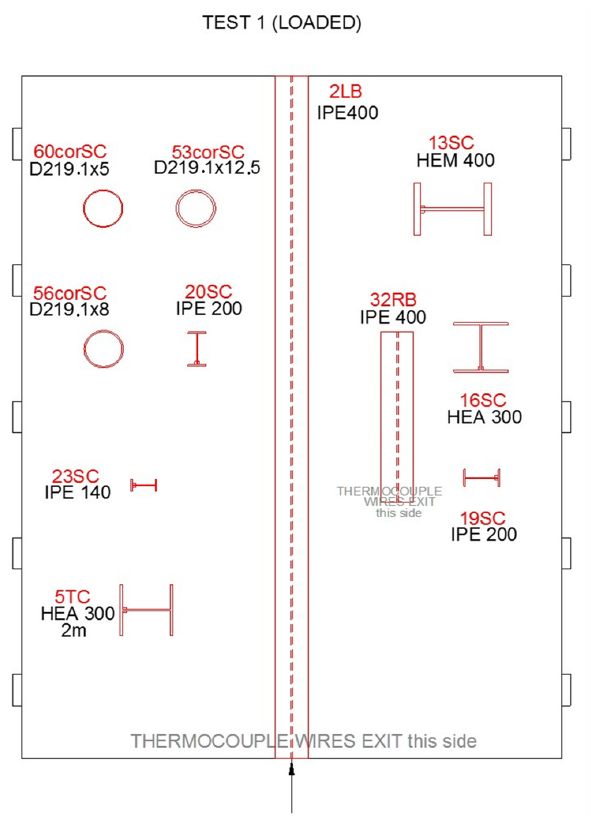
Figure 4. Typical disposition of specimens for a fire test according to EN 13381-8.